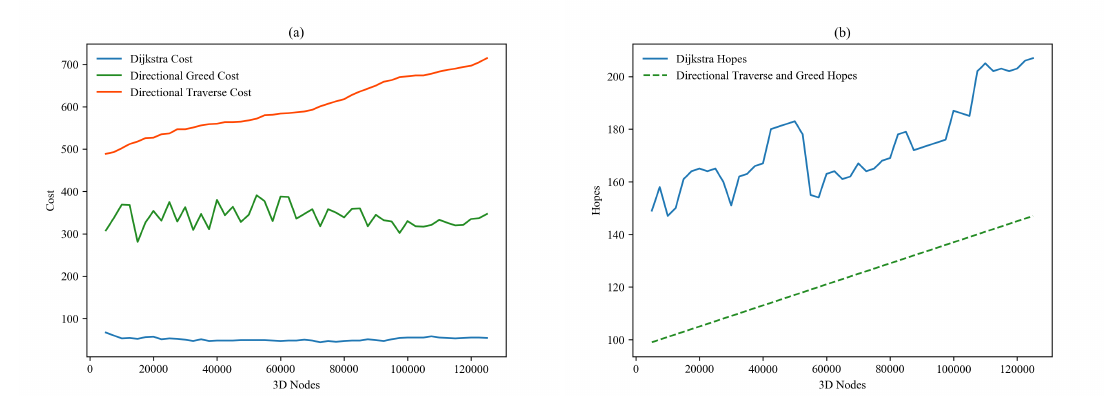
Figure 14. Cost and hops of the path in massive connected nodes in multilayer 6G